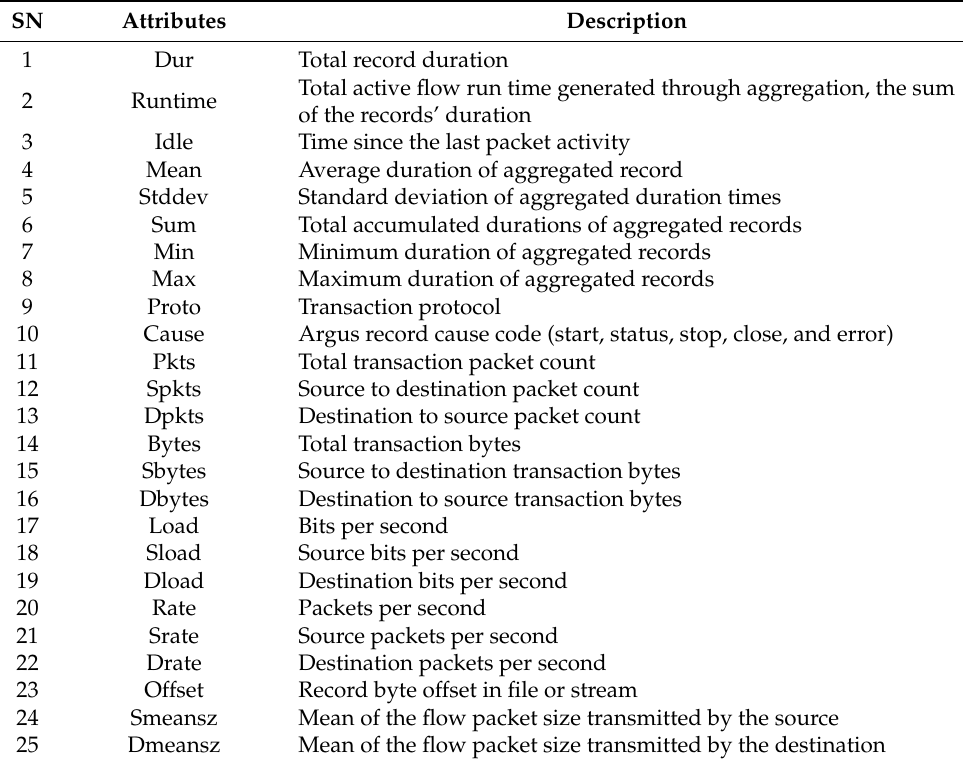
Table 2. Attribute’s description of CCD_IDSv1 dataset.